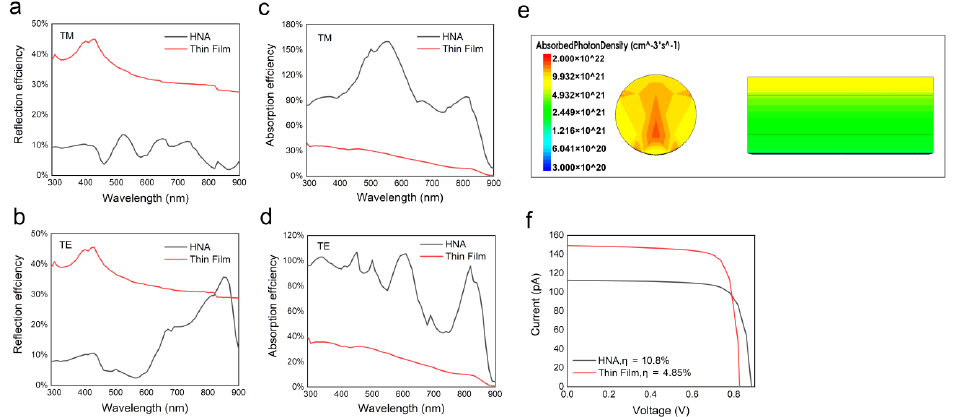
Figure 4. ( a – d ) The reflectance and absorptance of the HNA and thin-film structures for TM and TE polarized light, respectively. ( e ) Comparison of the cross-sectional optical generation profiles of the HNA and thin-film structures. ( f ) The current–voltage characteristics of the HNA and thin-film structures.